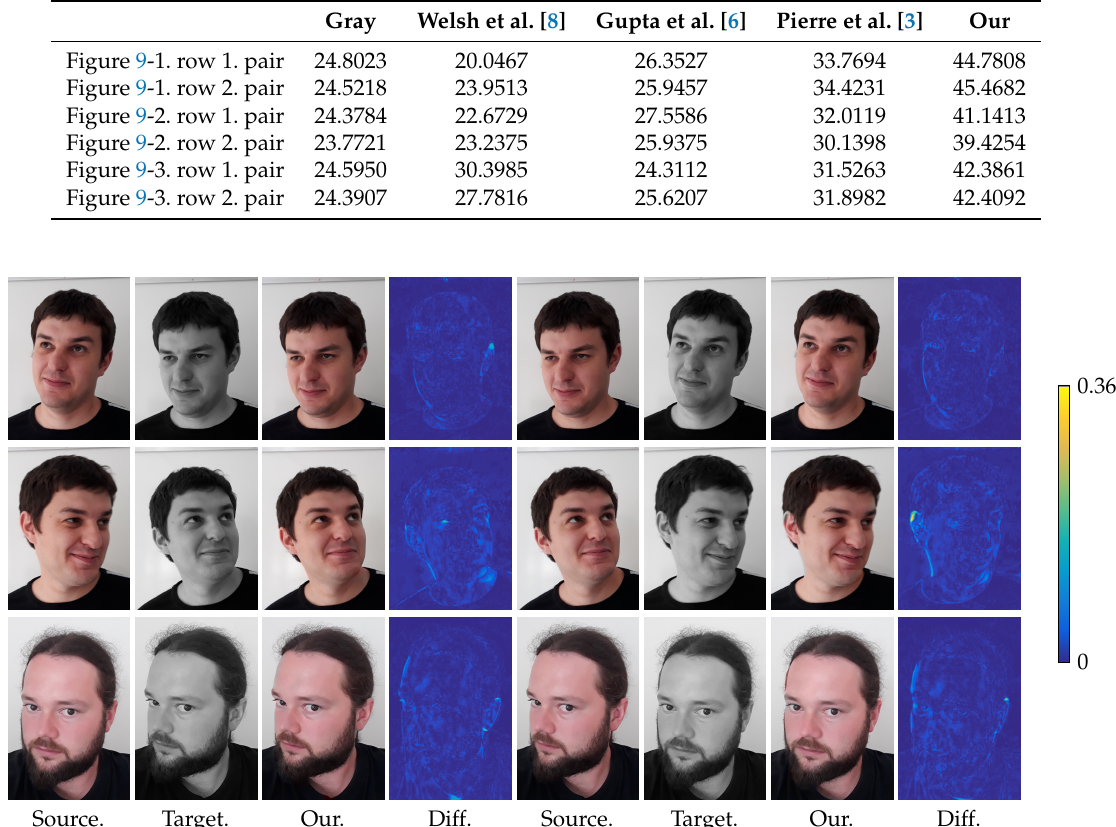
Figure 9. Multiple colorizations of known RGB-images with difference plots measured in Euclidean distance in R 3